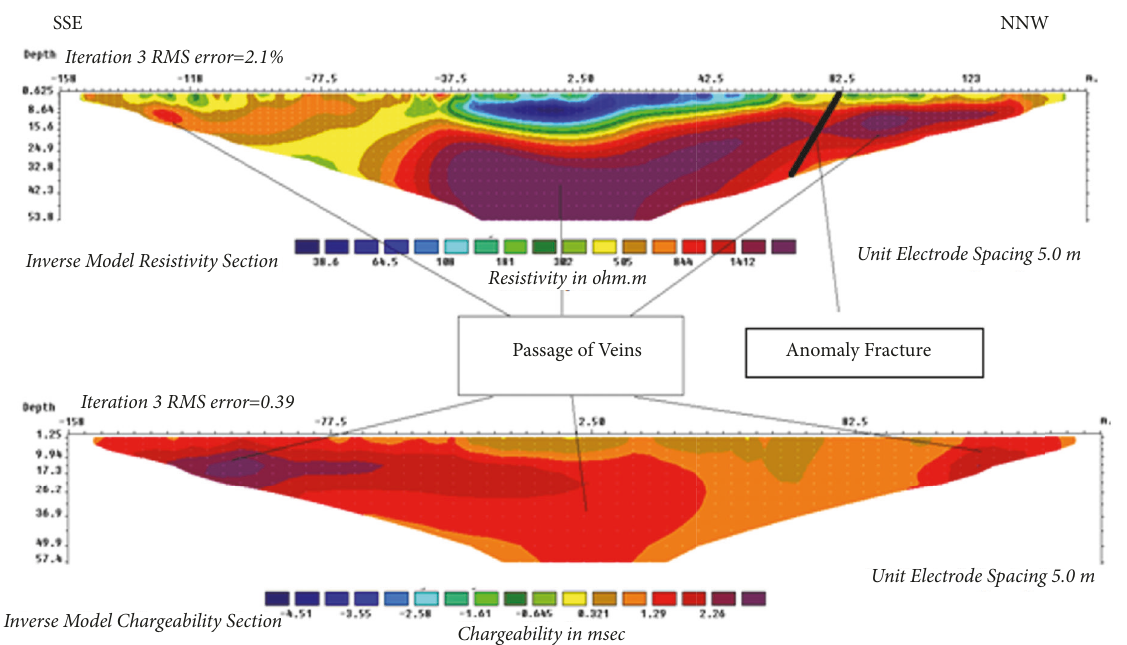
Figure 8: Inverse model resistivity and chargeability sections (Taroucht 1; direction: